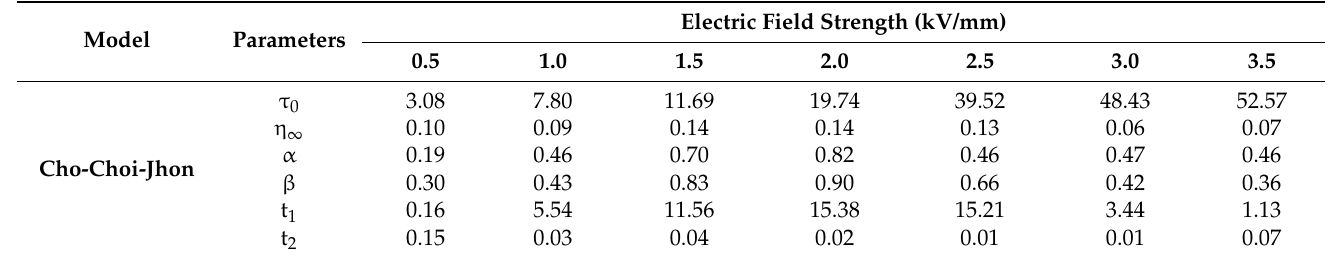
Table 1. Parameters of the CCJ equation fitting deduced from ZnFe 2 O 4 /PMA − based ER fluid.